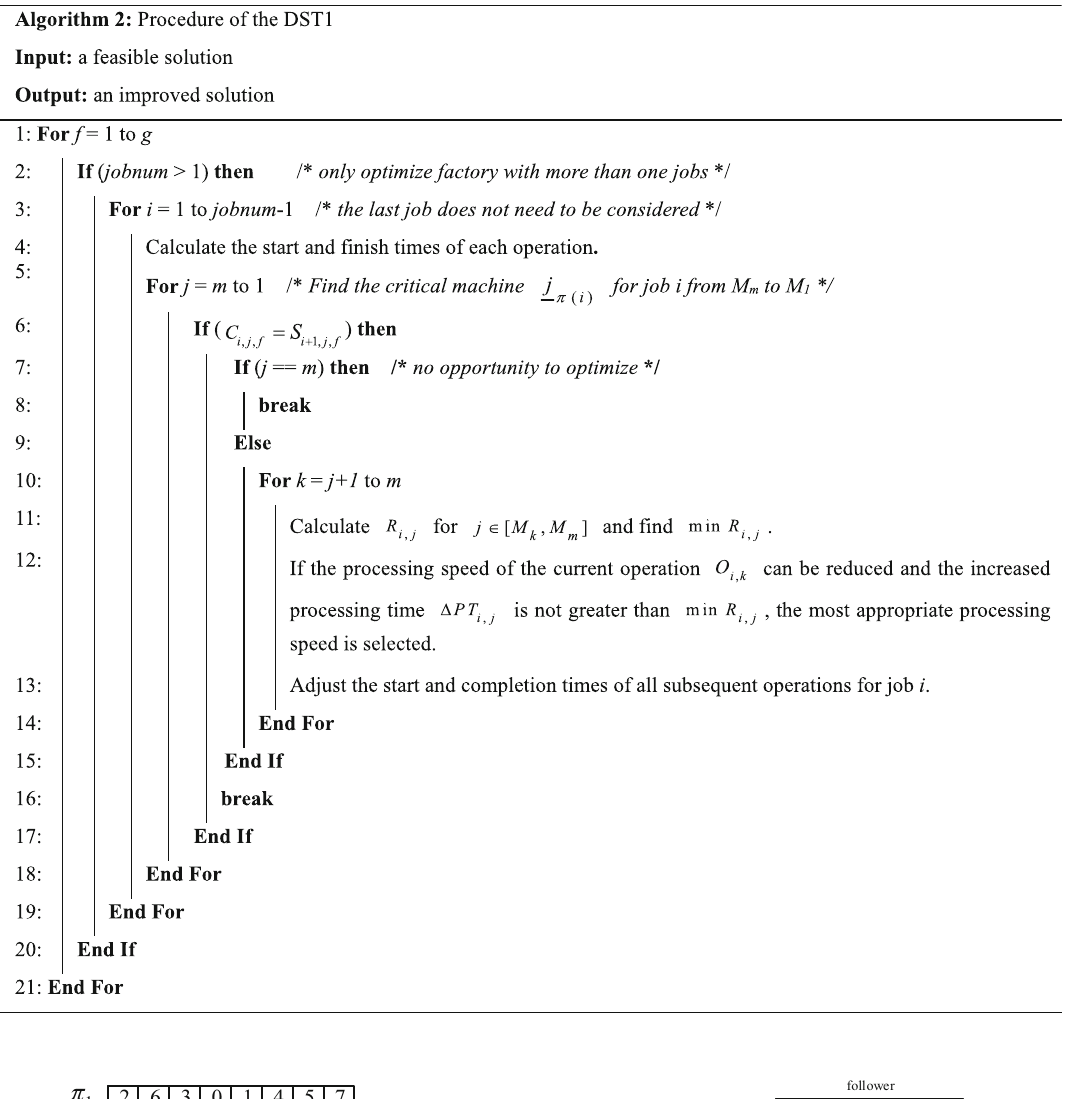
Then, two parents from the population are randomly selected, e.g., parent1 (cid:2) (1, 6, 7, 4, 0, 3, 5, 2) and parent2 (cid:2) (5, 2, 7, 0, 1, 4, 3, 6), the common gene pairs between parent 1 and the temporary set, i.e., (3, 5) and (5, 2), are sought and put into offspring 1 at positions 6–8. The same gene 7 was